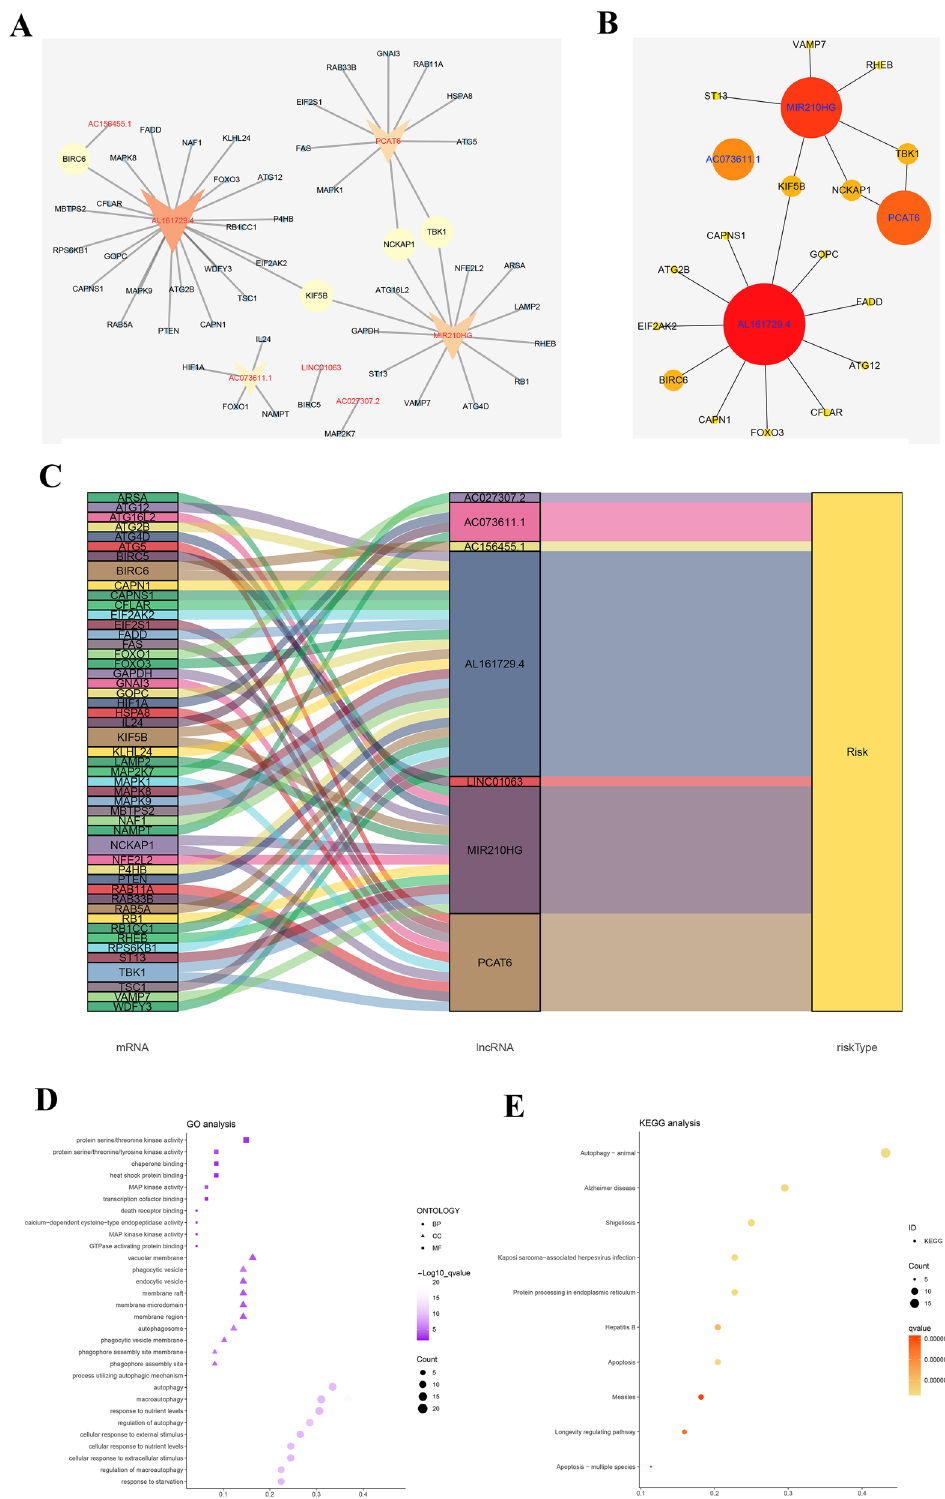
Figure 4. Co-expression network and enrichment analysis. ( A ) Edges and nodes in co-expression network; ( B ) Top 20 nodes in co-expression network; ( C ) Sankey diagram of lncRNAs and linked genes; ( D ) GO analysis of the genes in co-expression network ; (E ) KEGG analysis of the genes in the co-expression network. GO: Gene Ontology; KEGG: Kyoto Encyclopedia of Genes and